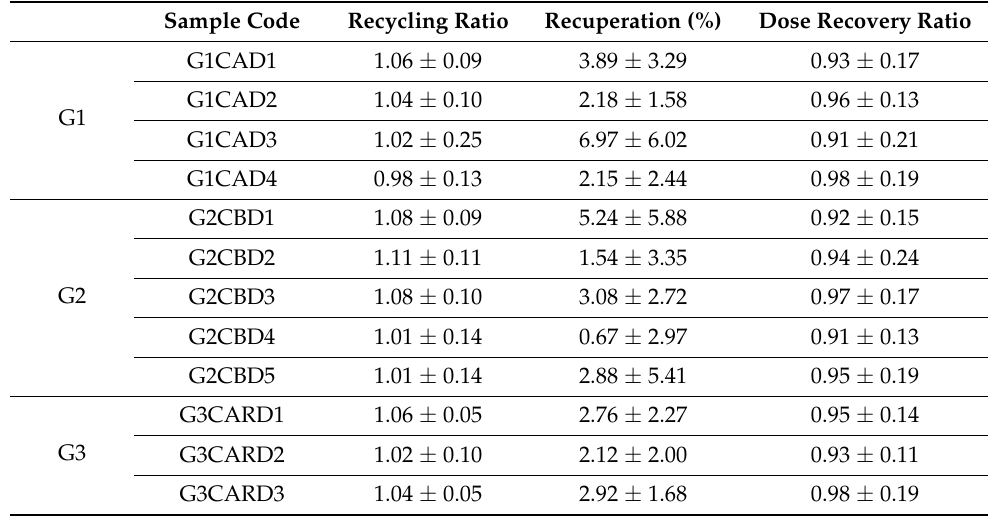
Table 5. Quality assurance parameters of the OSL